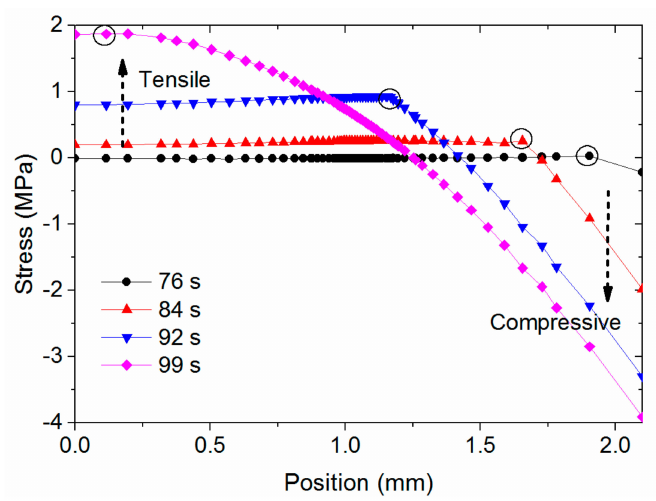
Figure 11. Stress evolution in stage 2.